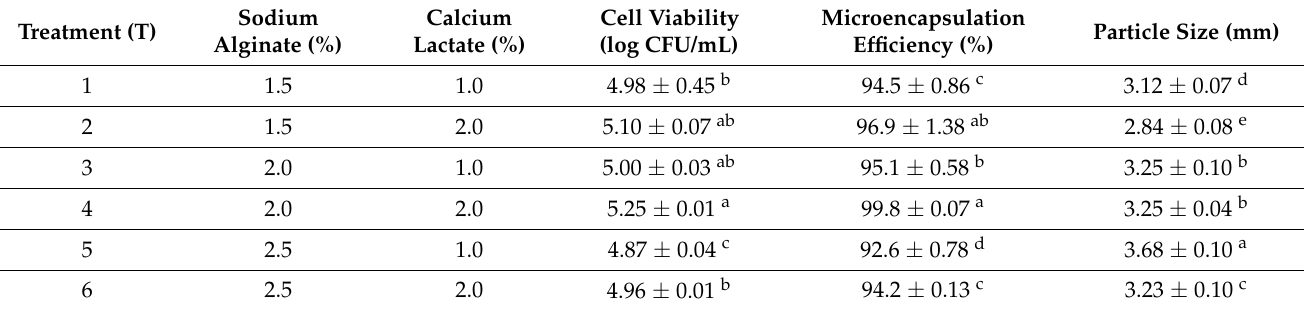
Table 1. Cell viabilities, microencapsulation efficiencies, and particle sizes of different concentration levels of sodium alginate and calcium lactate B. breve TISTR 2130 microcapsules.